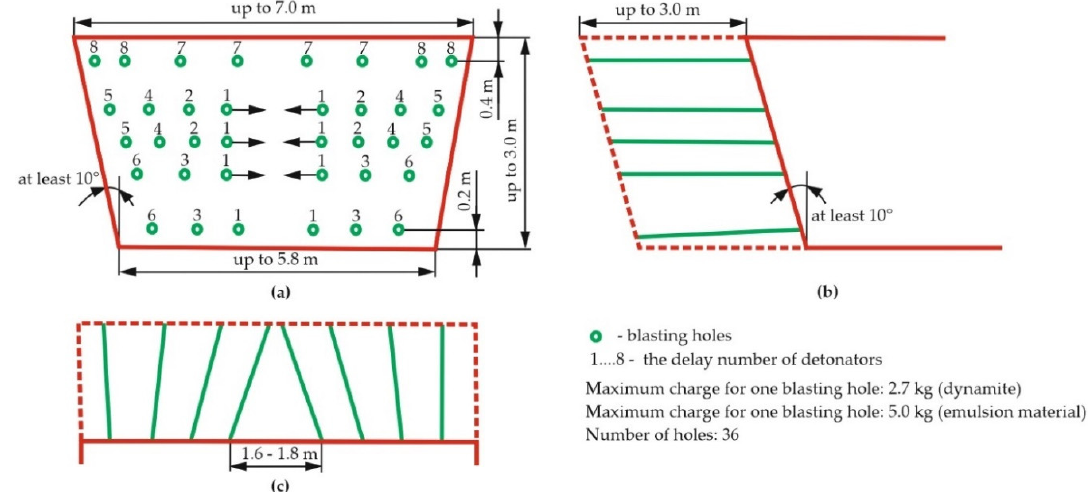
Figure 2. An example of the arrangement of blast holes in the room: ( a ) cross section; ( b ) side view; ( c ) top view.